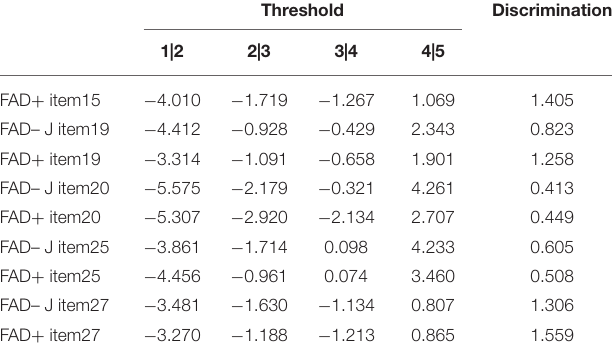
TABLE 4 | Estimated parameters in the generalized partial credit model for each subscale.